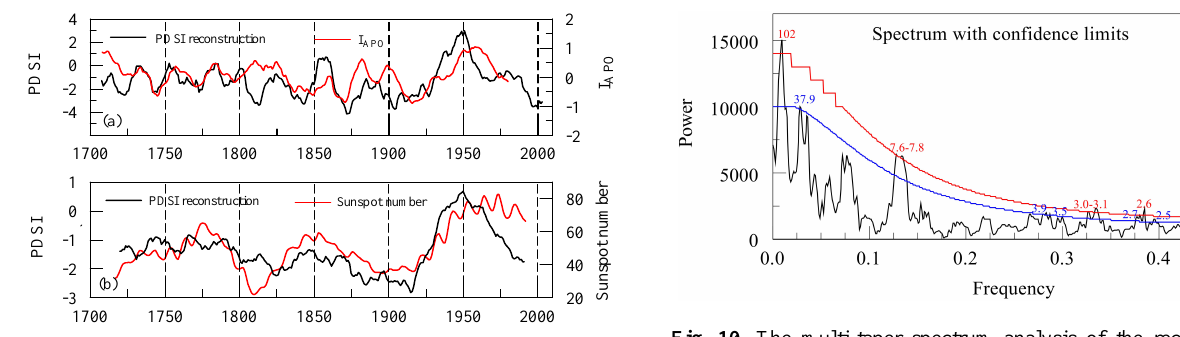
Fig. 10. The multi-taper spectrum analysis of the reconstructed PDSI. The blue line and red line show the 95 and 99% confidence limits,